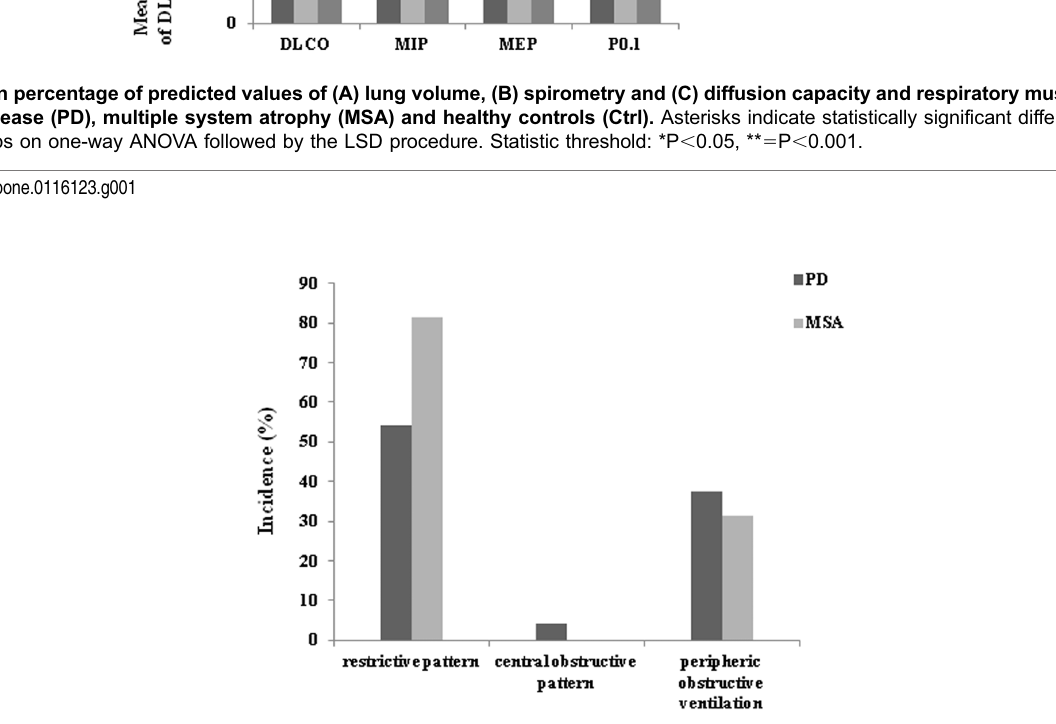
Fig. 2. Incidence of restrictive or obstructive pattern of ventilatory dysfunction in Parkinson’s disease (PD) and multiple system atrophy (MSA).